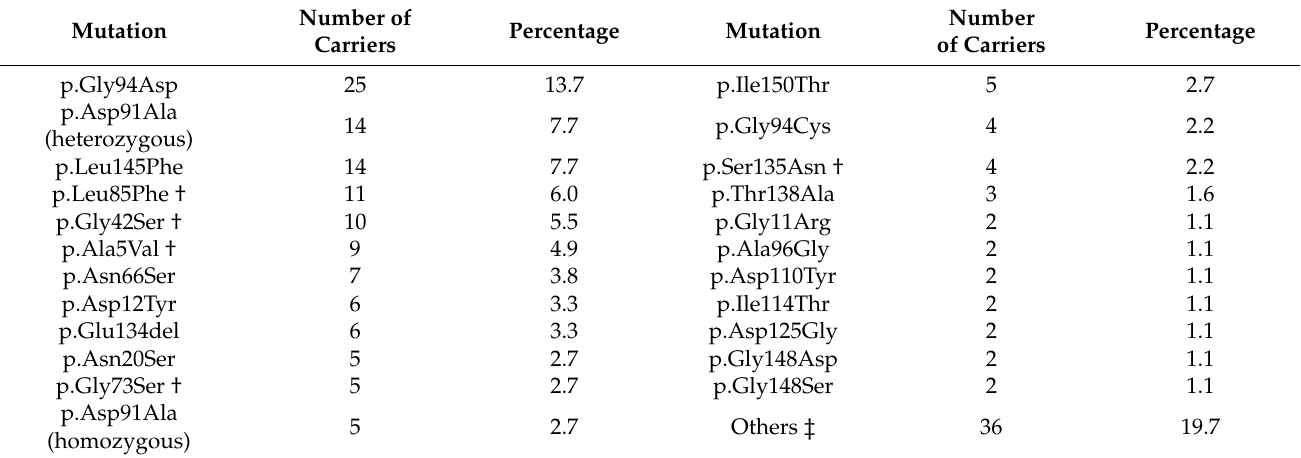
Table 1. List of SOD1 mutations in order of decreasing frequency in our series ( n = 183). Mutation